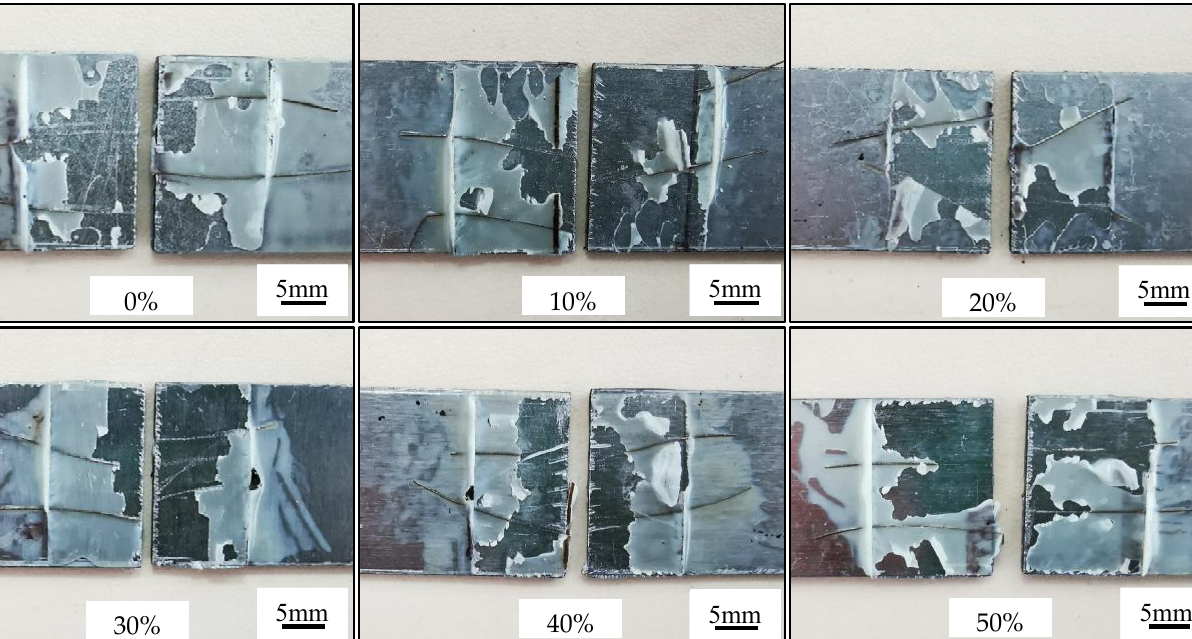
Figure 9. ( a ) Lap shear strength of AS60/60 coating at different reduction ratios; ( b ) surface rough- ness (Ra) of AS60/60 coating at different reduction ratios. The lap shear strength was 22.00 ± 1.25 MPa in the hot-dipped AS60/60 coatings, and was 22.15 ± 1.25, 21.75 ± 1.25, 21.50 ± 1.35, 21.75 ± 1.20, 21.50 ± 1.40 MPa, respectively in the cold-rolled AS60/60 coatings from 10% to 50% reduction ratio, indicating the results are basically consistent. The reason is that, in spite of rapid diffusion channels formed during cold rolling, the cohesive forces of the coating and the adhesive agent are both larger than the adhesive force between them, and this adhesive force corresponds to the shear strength, so this strength will not change with the cold rolling reduction ratio. The surface roughness of the AS60/60 coatings at different cold rolling reduction ra- tios was shown in Figure 9b. The surface roughness of the AS60/60 coatings decreased with the increase of cold rolling reduction ratio, and was stabilized at the cold rolling reduction ratio of 40% and above. The hardness of the Al layer in the hot-dipped coatings and the cold-rolled roller surface was about 70 HV (Ra = 1.5 μ m) and 810 HV (Ra = 0.3 μ m), respectively, so the surface roughness of the rollers would be transferred to the Al layer during the cold rolling. As the cold rolling reduction ratio increased, the Al layer was gradually thinned, and its duplicated roller surface roughness was intensified, which resulted in a decrease in surface roughness of coatings. When the reduction ratio was 40% and above, the surface roughness of coatings was stable. This was because the Al layer 0